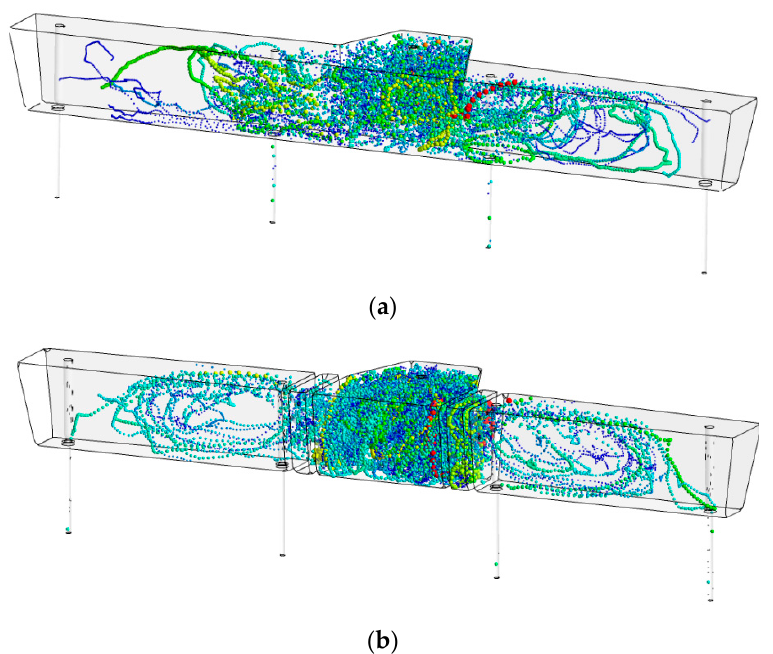
Figure 15. The influence of DPRW structure on the trajectory of inclusions. ( a ) C 0 D 0 ; ( b ) C 2 D 1 .